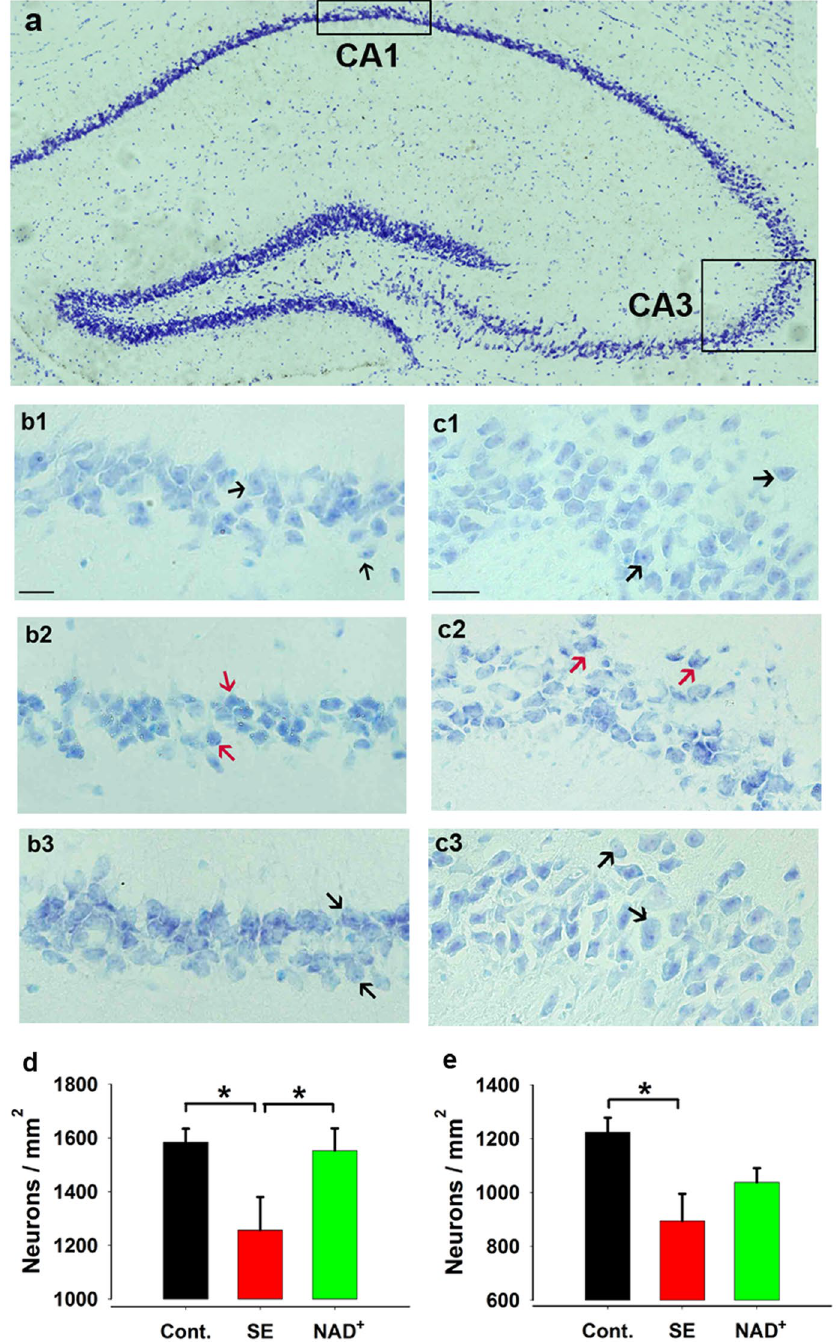
Figure 4. Early-stage intervention with NAD + suppressed neuronal loss in hippocampus of SE model mice at SRS stage. ( a , b 1–3, c 1–3) Coronal dorsal hippocampal sections were underwent Nissl staining with 0.1% thionine. ( a ) The regions used for cell counting in CA1 and CA3. Examples of intact neurons or shrunken abnormal neurons are marked with black and red arrows, respectively, in the CA1 region ( b 1– b 3) and the CA3 region ( c 1– c 3). Scale bars, 20 µ m. Statistical results of CA1 ( d ) and CA3 ( e ). The vertical axis shows the number of intact neurons per mm 2 . Cont., SE, and NAD + represent the control, SE model mice, and NAD + -treated SE mice, respectively. Each group has 4 mice (six sections per mice). Data are represented as mean ± SEM. * P < 0.05, ** P < 0.01, *** P <